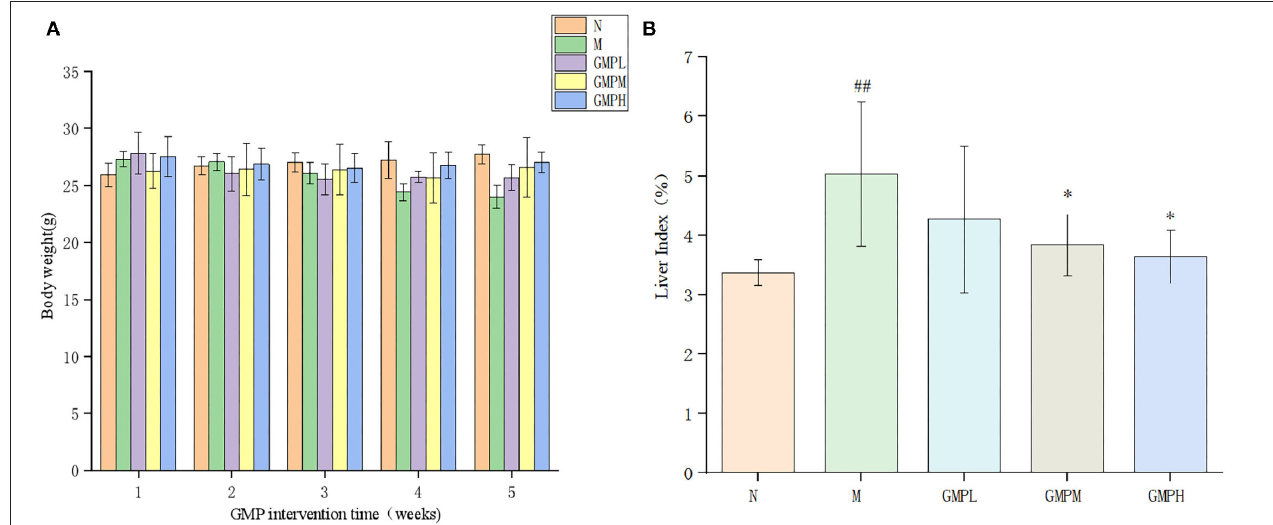
FIGURE 1 | Changes of body weight and liver index during GMP intervention. (A) Body weight. (B) Liver index. The data in the figure are expressed as mean ± SD ( n = 6). Significance of difference: *means p < 0.05, **means p < 0.001, compared with group M. ## means p < 0.001, compared with group N. GMP, germinated mung bean polyphenol.